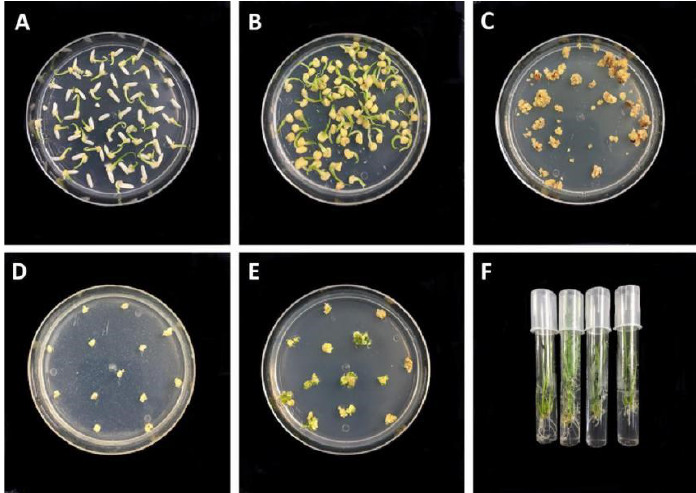
Figure 3. Process steps of genetic transformation. ( A ): Callus induction; ( B ): Callus screening; ( C ): The first screening of calli; ( D ): The second screening of calli; ( E ): Plantlet differentiation; ( F ): Rooting.